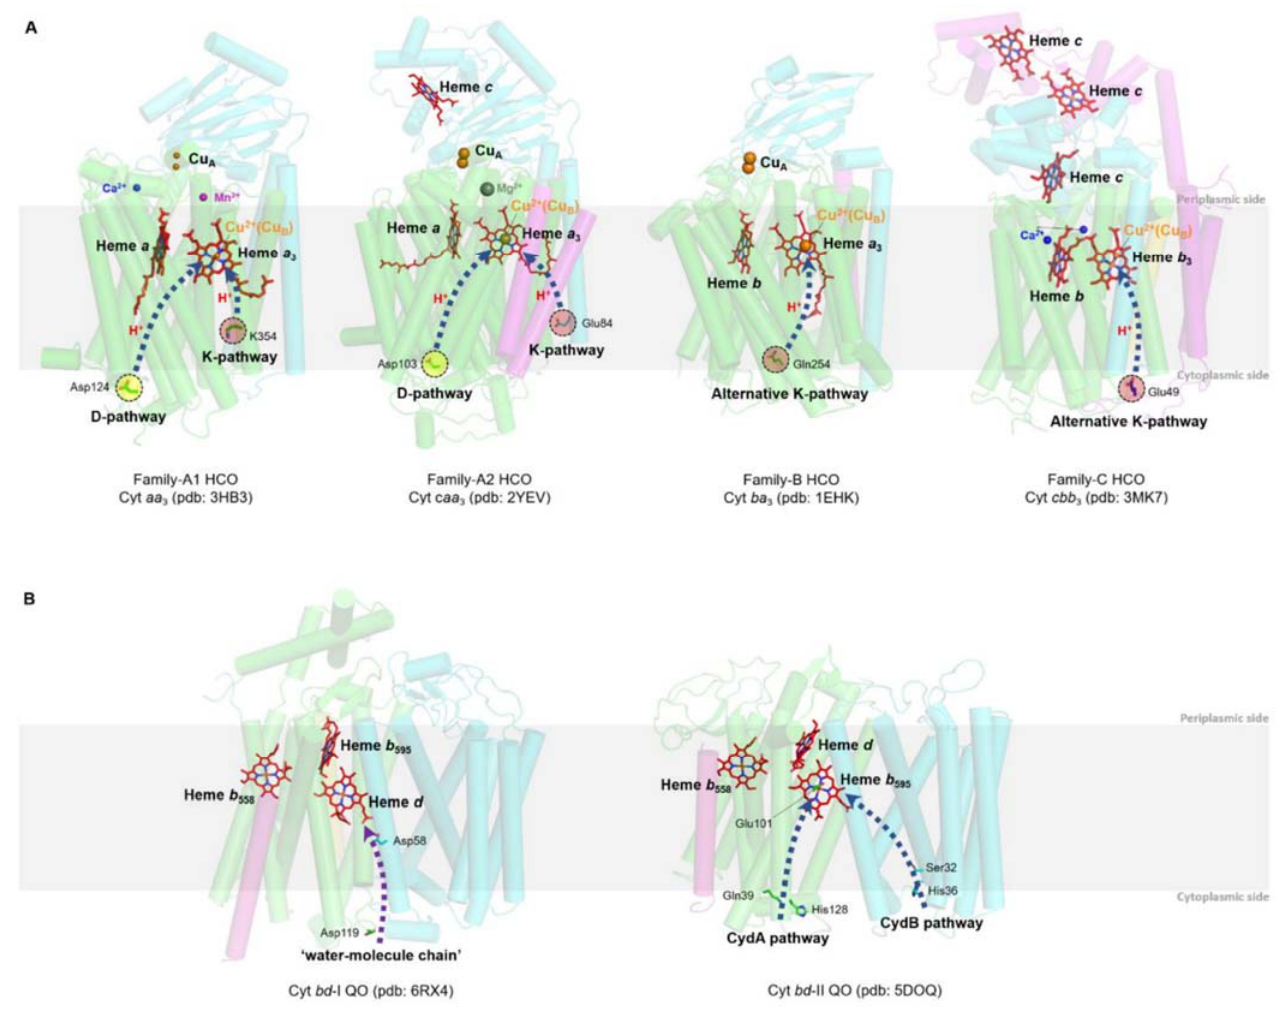
Figure 2. Prosthetic group arrangements and proton pathways of typical bacterial HCOs ( A ) and bd QOs ( B ). ( A ) Representative structures of HCOs of A (divided into A1 and A2), B, and C subfamilies. Protein peptides, heme cofactors, and ions are shown as cartoons, sticks, and spheres, respectively. SUs I of families A and B, SU III of family A and CcoN of family C are colored in green; SUs II of families A and B, and CcoO of family C are colored in cyan; SU IV of family A, SU Iia of family B, and CcoO of family C are colored in magenta; the 30 ‐ mer peptide in family C HCO is colored in yellow. The blue dashed arrows indicate the proton pathways inside each HCO, with the amino acid residues at the entry point of each pathway marked with dashed cycles. ( B ) Structures of Cyt bd ‐ I and bd ‐ II QOs. Protein peptides and heme cofactors are shown as cartoons and sticks with subunits CydA and CydB colored in green and cyan, and CydX in bd ‐ I QOs and CydS in bd ‐ II QOs colored in magenta, respectively. The purple dashed arrow indicates the ‘water ‐ molecule chain’ ob ‐ served between residues Asp119 (subunit A) and Asp58 (subunit B) in bd ‐ I QOs. The blue dashed arrows indicate two proposed proton pathways in bd ‐ II QOs. Figures are prepared with PyMOL (Molecular Graphics System, LLC) https://www.pymol.org (accessed on 20 December 2021). Bacterial A ‐ family HCOs include aa 3 ‐ type C c Os ( aa 3 ‐ HCO, in some cases caa 3 ‐ HCO),